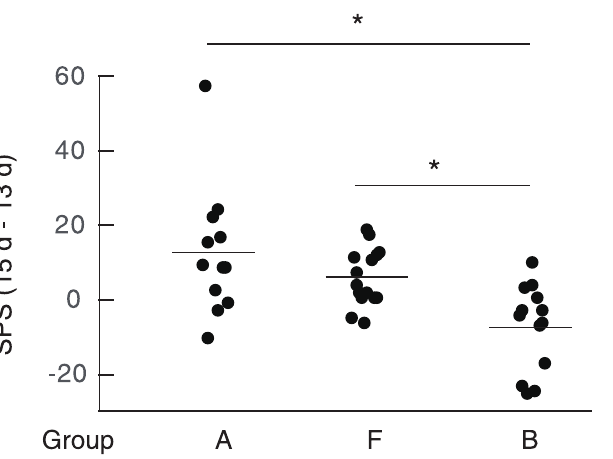
ATP concentration in the synovial fluid of control mice was 0.40 ± 0.25 μ M. On day 2 after injection of MIA, we found that volume of the synovial fluid increased about five-fold com- pared to that of the control mice; however, we failed to determine the ATP concentration because ATP assay was strongly interfered for unknown reasons.